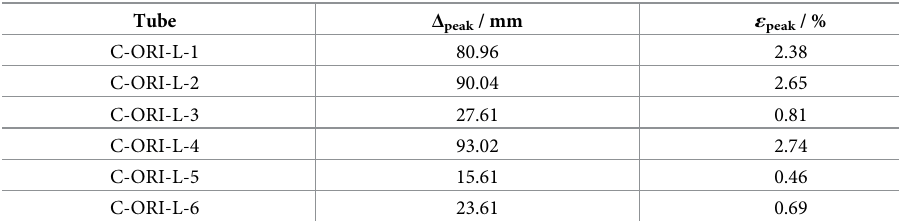
Table 4. Values of Δ peak and ε peak .